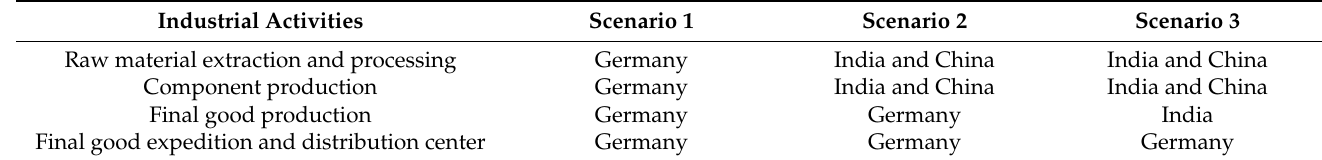
Table 5. Geographical areas where the main industrial activities are carried